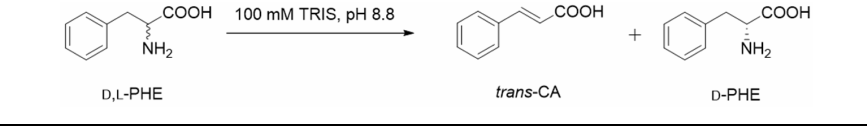
Table 4. Conversions and enantiomeric excess values of the operational stability tests of immobilized Pc PAL biocatalysts in the ammonia elimination reaction of d , l -phenylalanine. All the measurements were performed in triplicate, and the standard deviations were below 5%. For experimental conditions see Supplementary Materials Section 3.4.